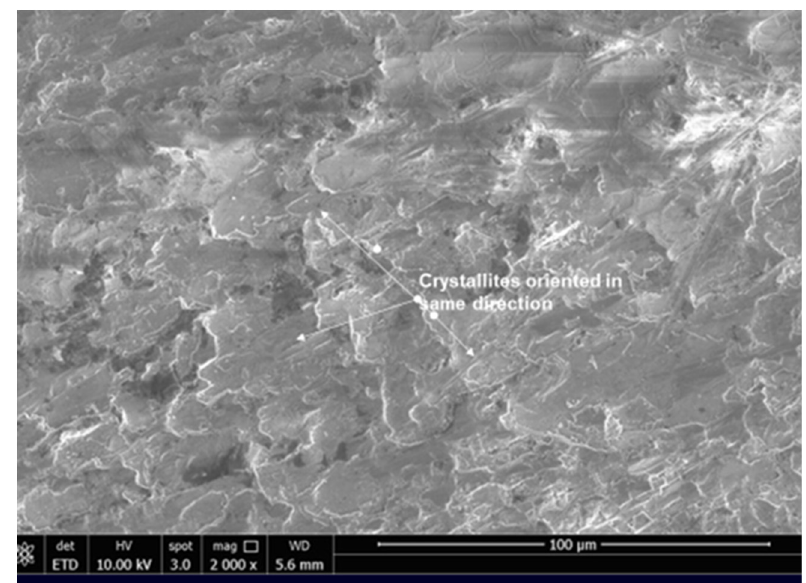
Figure 6. The microstructure of Fe-ZnSe crystals at 10 kV small crystallites in identical orientation and boundaries.